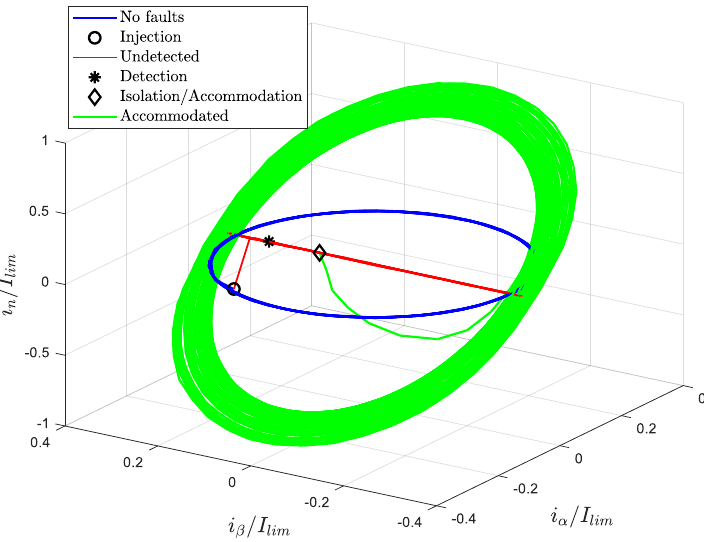
Figure 17. Current phasor trajectory in the Clarke space with open circuit on phase a ( I lim = 92 A).